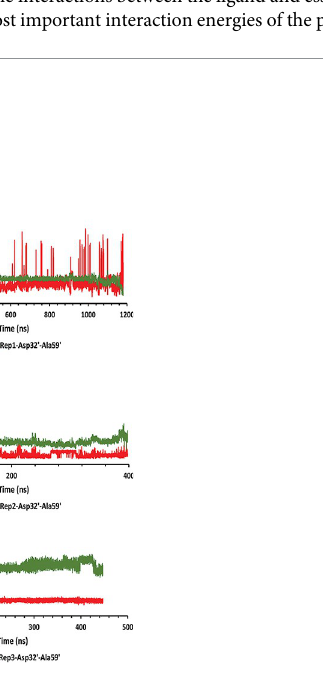
Fig 14. The details of distances between particular parts of compound 9 complexed with HTLV-1 protease when Asp32 of chain B was protonated in three replicas. A , B , and C , The distance between COMs of both nitrobenzene rings and benzene rings, which were in a position that could form pi-pi intramolecular interactions in all replicas. These plots prove that these fragments were so close together during the simulation. D , E , and F , The distance between COMs of Ala59 andAla59 0 and also Asp32 0 Ala59 0 in all replicas (these plots should be checked with Fig 3).